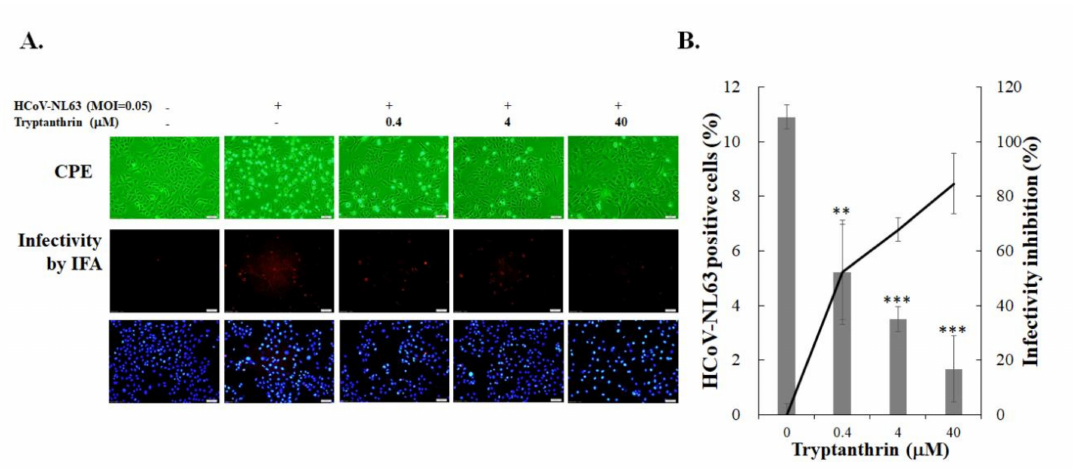
Figure 5. Tryptanthrin inhibited HCoV-NL63 infectivity in human airway epithelial cells. Calu-3 cells were infected with HCoV-NL63 and immediately treated with tryptanthrin for 36 h at 32 ◦ C. Images of relative CPE levels in each group were captured ( A , top). In addition, the cells were subjected to immunofluorescence staining with anti-HCoV-NL63 antibodies plus secondary antibody Alexa Fluor anti-mouse IgG ( A , middle) and DAPI ( A , bottom). Infectivity inhibition activity was determined based on the change in the percentage of HCoV-NL63-positive cells ( B ). + , add; − , not add; **, p value < 0.01;